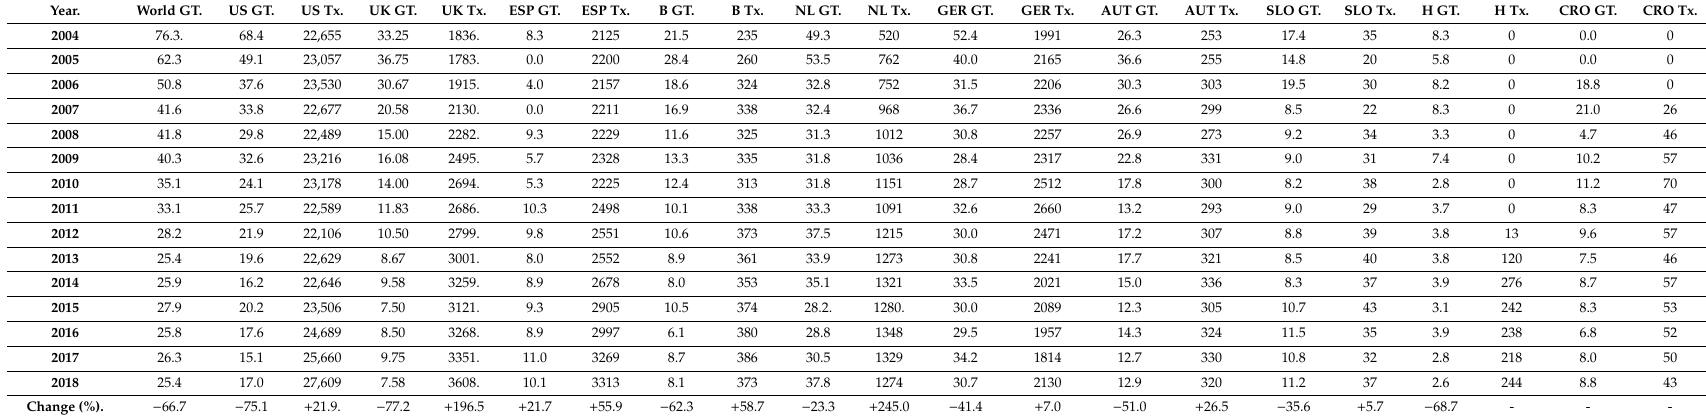
Table 1. The respective year, number of search queries using Google Trends TM , and the total number of kidney transplantations performed (deceased donor and living